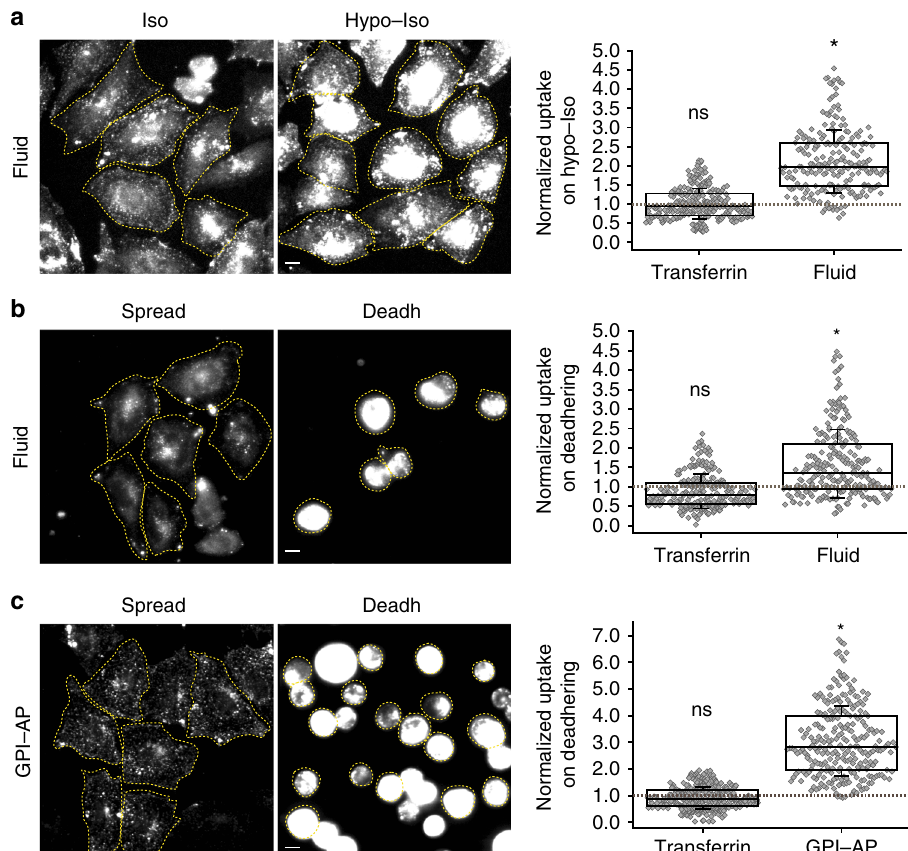
Fig. 2 Endocytic pathways differ in their response to decrease in tension. a Fluid-phase and transferrin uptake in CHO cells under isotonic conditions (Iso) or immediately after shifting from the hypotonic to isotonic state (Hypo – Iso) by incubating cells with A647-Tf (Transferrin) or TMR-Dex (Fluid). Wide- fi eld images (left) show the extent of endocytosed fl uid-phase in isotonic or hypotonic-isotonic (Hypo – Iso) conditions. Box plot (right) show the extent of TMR-Dex and A647-Tf endocytosis in the Hypo – Iso condition normalized to those measured in the isotonic condition (gray dashed line) ( n = transferrin (266), fl uid (214)). b Fluid-phase and transferrin uptake in CHO cells using TMR-Dex (Fluid) and A647-Tf (Transferrin) for 3 min when the cells are adherent (Spread) or during de-adhering (Deadh). Wide- fi eld images (left) show the extent of endocytosed fl uid-phase in Spread and during de-adhering condition (Deadh). Box plot (right) shows the extent of TMR-Dex and A647-Tf endocytosis in the de-adhered condition normalized to that measured in the Spread condition (gray dashed line) ( n = transferrin (246), fl uid (244)). c GPI – AP and transferrin uptake in CHO cells using fl uorescent folate to label GPI-anchored folate receptors (GPI – AP) and A647-Tf (Transferrin) in adherent cells (Spread) or during detachment (Deadh). Wide- fi eld images (left) show the extent of endocytosed GPI-anchored folate receptor in Spread and during the de-adhering condition. Box plot (right) shows the extent of A647-Tf and folate receptor endocytosis in the de-adhered condition normalized to those measured in the Spread condition (gray dashed line) ( n = transferrin (321), GPI – AP (261)). Box plot shows median, 25th and 75th percentile, and whiskers show the standard deviation. Individual data points are overlaid on box plot where each data point is the mean intensity per cell. The ‘ n ’ indicates total number of cells in each condition pooled from two different experiments with duplicates per experiment; * p < 0.001, ns not signi fi cant by Mann – Whitney U test. Scale bar, 10 µ